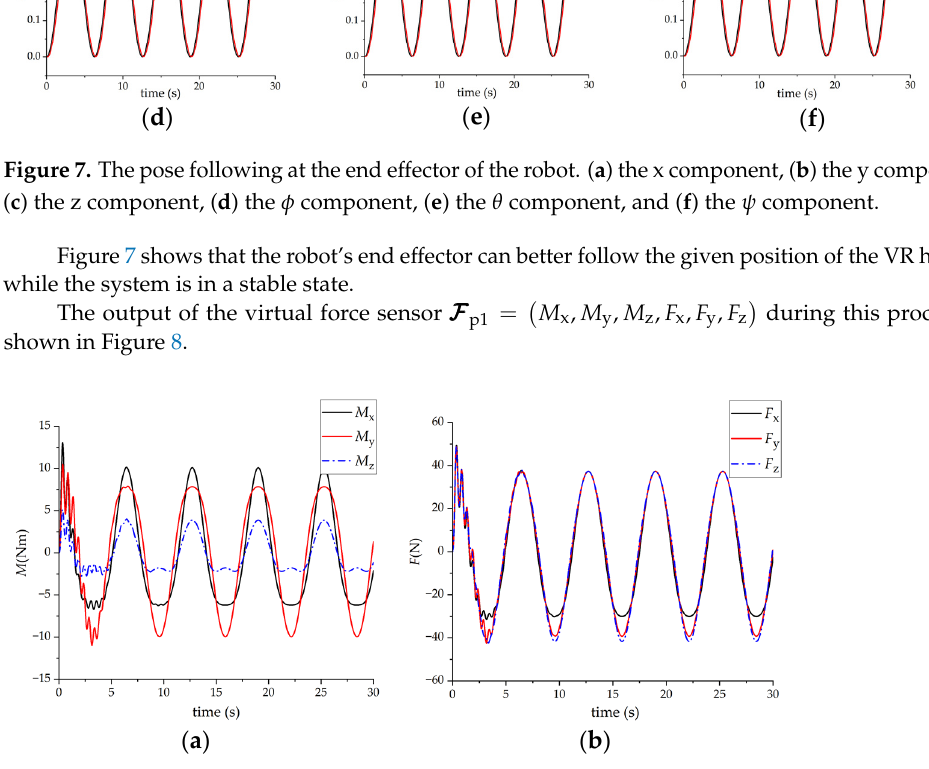
Figure 9. The simulation model of two people cooperatively carrying objects.